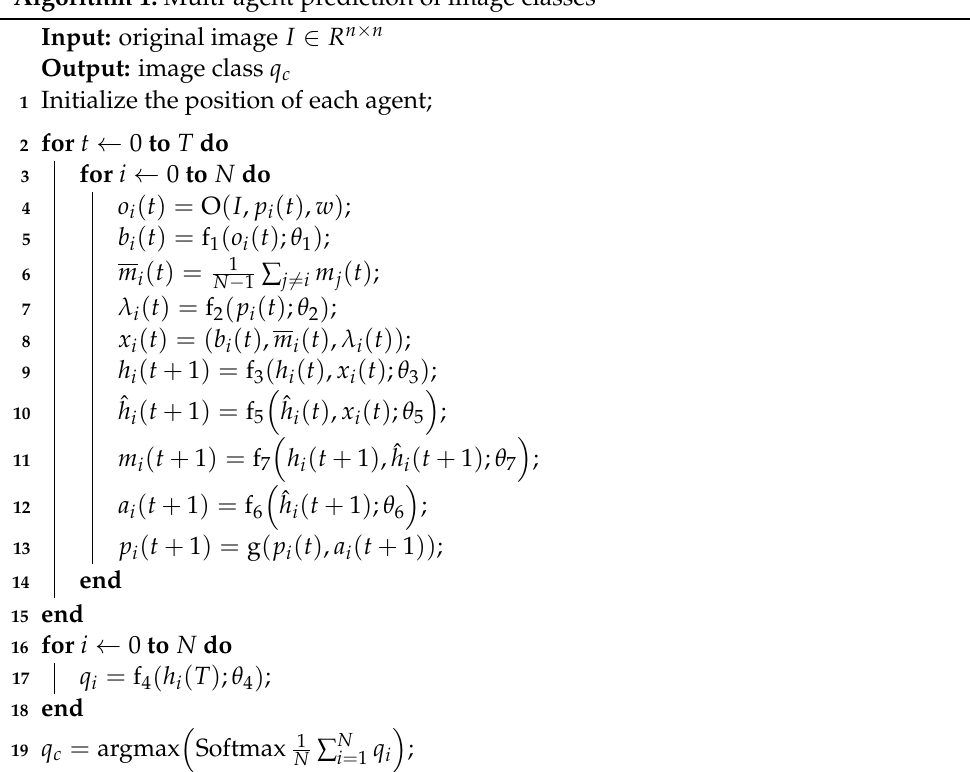
Algorithm 1: Multi-agent prediction of image